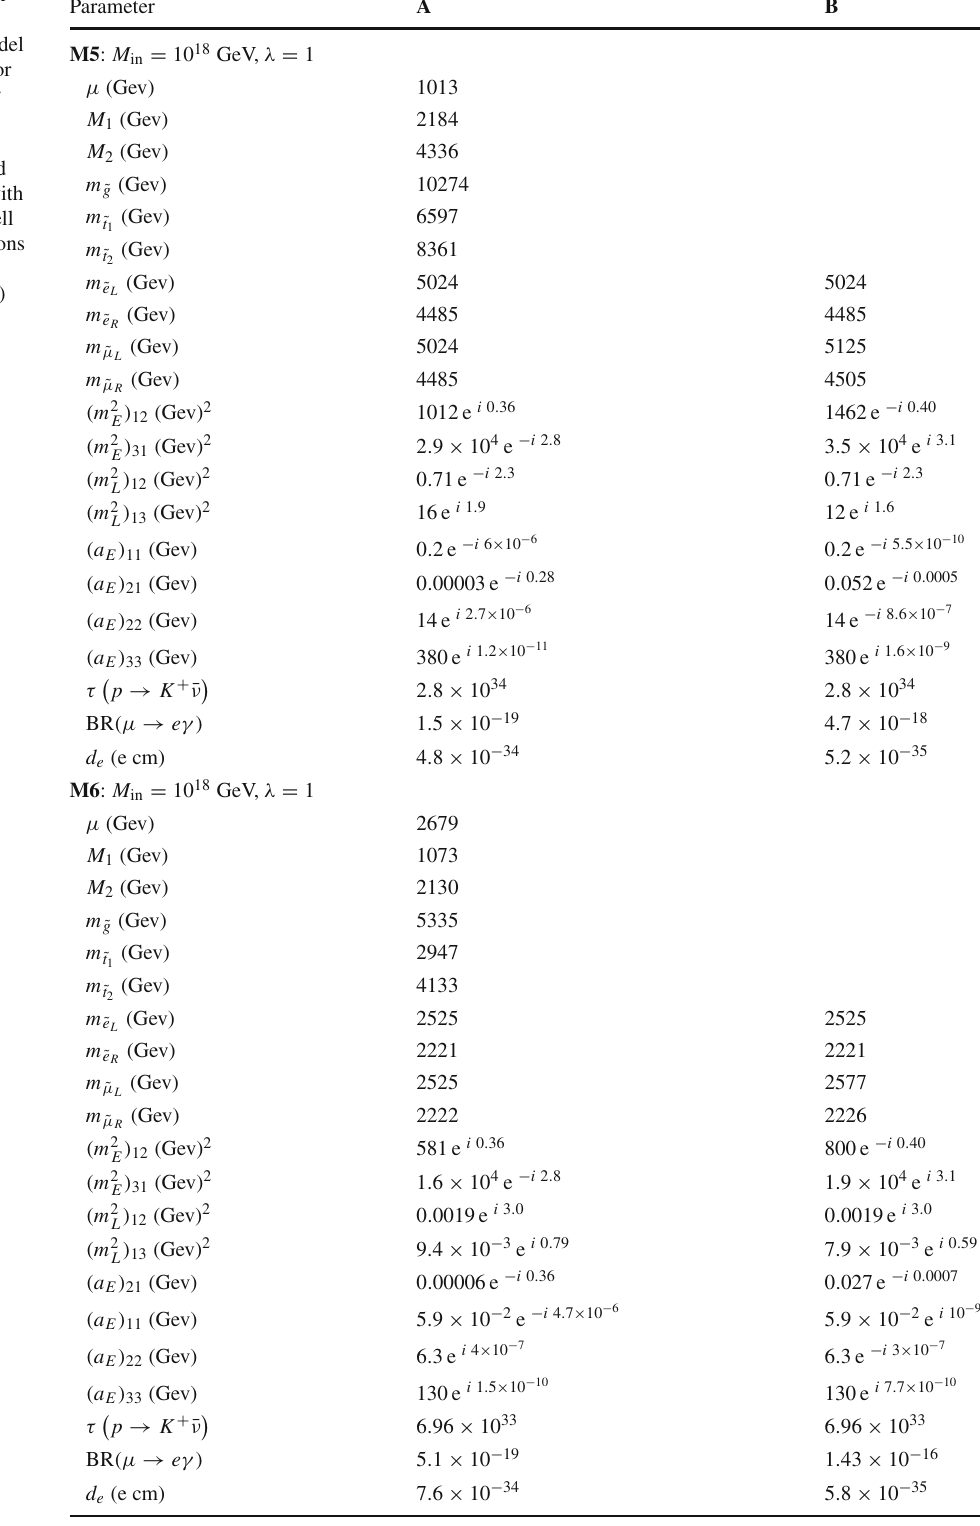
Table 3 Benchmark points in model M5 with m 1 / 2 = 6000 GeV and in model M6 with m 1 / 2 = 3000 GeV. For M5, m 2 = 8385 GeV, and for M6, m 2 = 4470 GeV. We list values of the parameters relevant for BR (μ → e γ) and the electron EDM obtained with flavor choices A and B , as well as the corresponding predictions for (cid:2) (cid:3) τ , BR (μ → e γ) p → K + ¯ ν and the electron